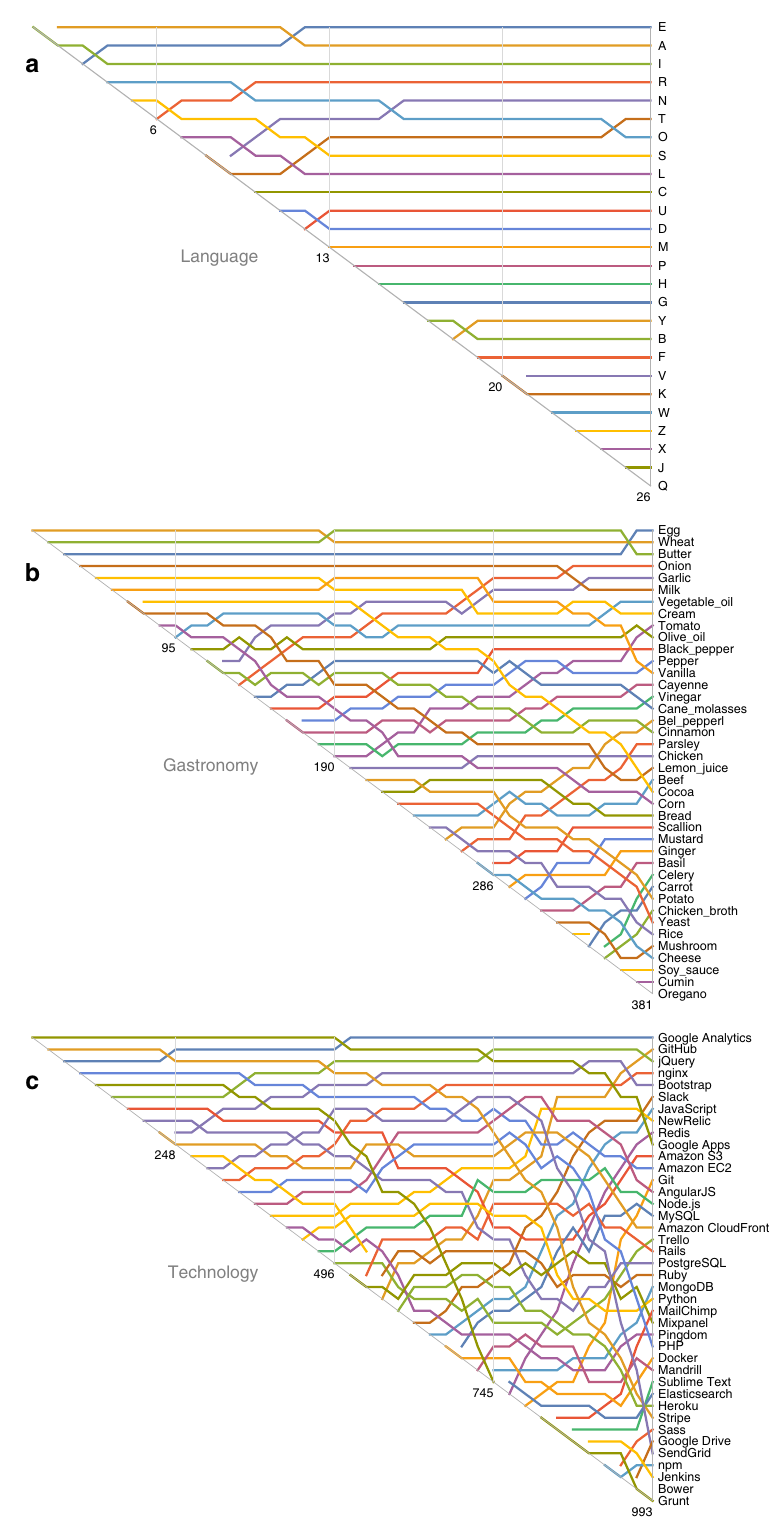
Fig. 2 a – c Crossovers in the mean usefulness of components. The relative usefulness of different components changes as the number of components we possess increases. For example a , if you are only allowed six letters, the ones that show up in the most words are a , e , i , o , s , r . For gastronomy b and technology c , for clarity we only show the 40 components most useful when we have all N components. A pure short-sighted strategy attempts to acquire components in the order that they intersect the diagonal, whereas a pure far-sighted strategy attempts to acquire them in the order that they intersect a vertical. If there are no crossovers, the strategies are the